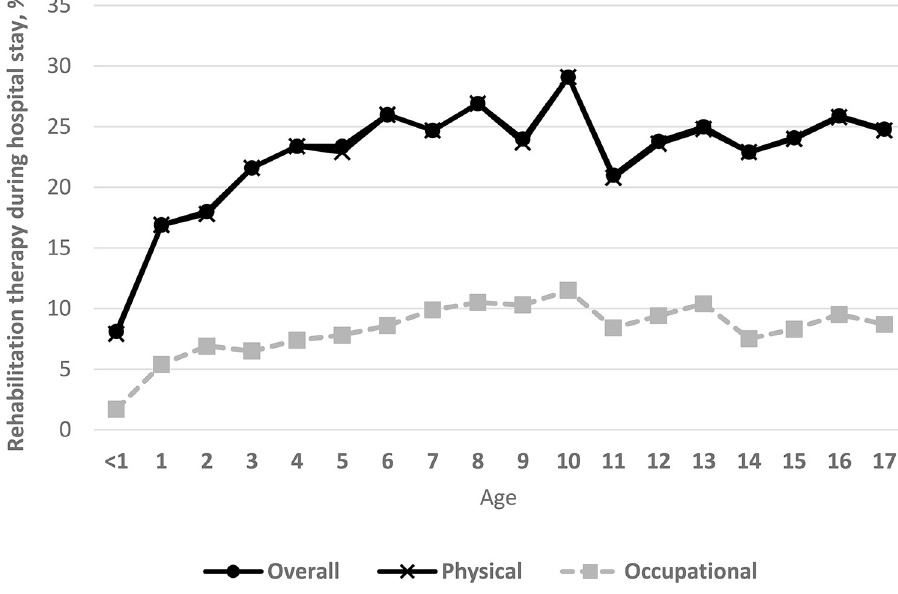
Fig 3. Distribution of physical/occupational therapy according to age in Korean intensive care units. ICU, intensive care unit. Overall p for trend < 0.01.